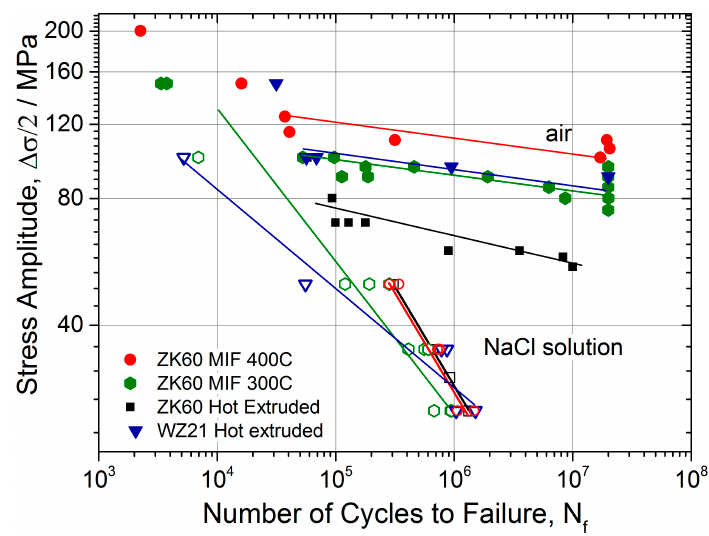
Figure 5. Fatigue life (S-N) diagram for the ZK60 alloys after different processing and alloy WZ21 in air and 0.9% NaCl solution (filed symbols refer to the tests in dry air while open symbols of the same shape and color represent the results of the tests in 0.9% NaCl solution).